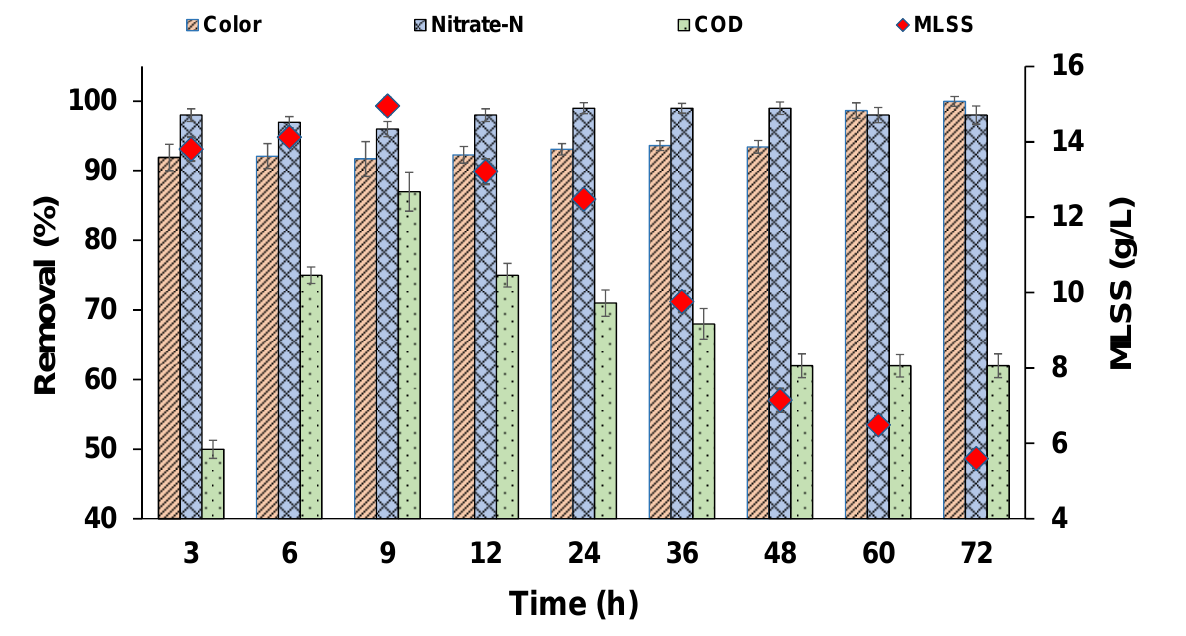
Figure 8. Profiles of colour, COD, NO 3 − -N, and MLSS.